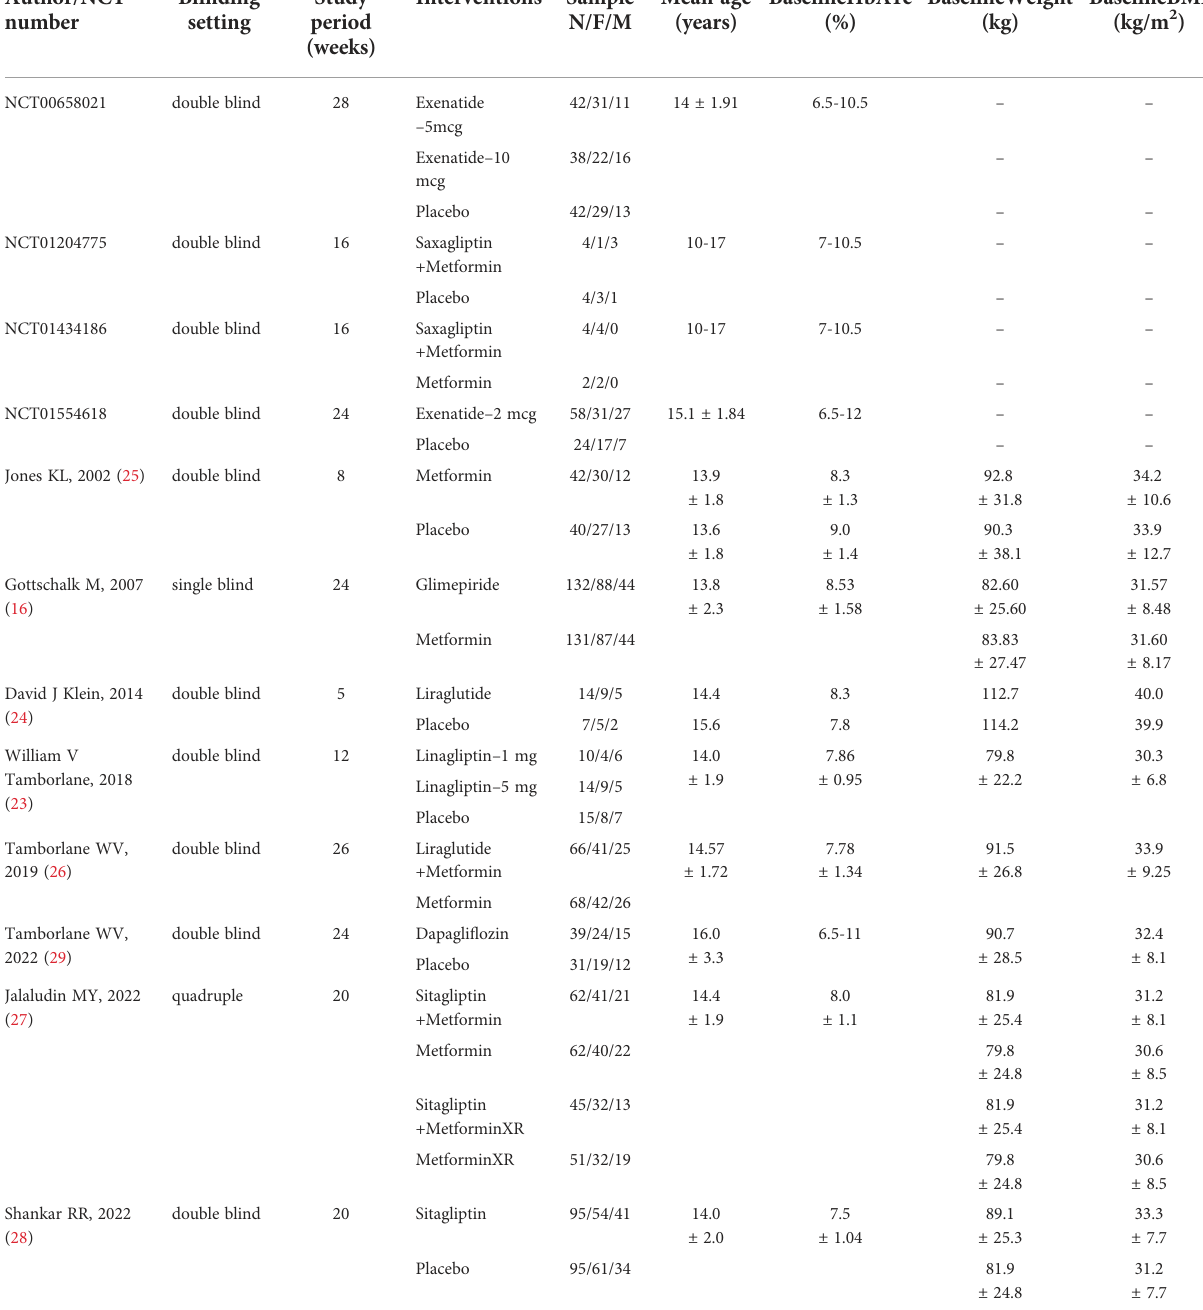
TABLE 1 Characteristic of included